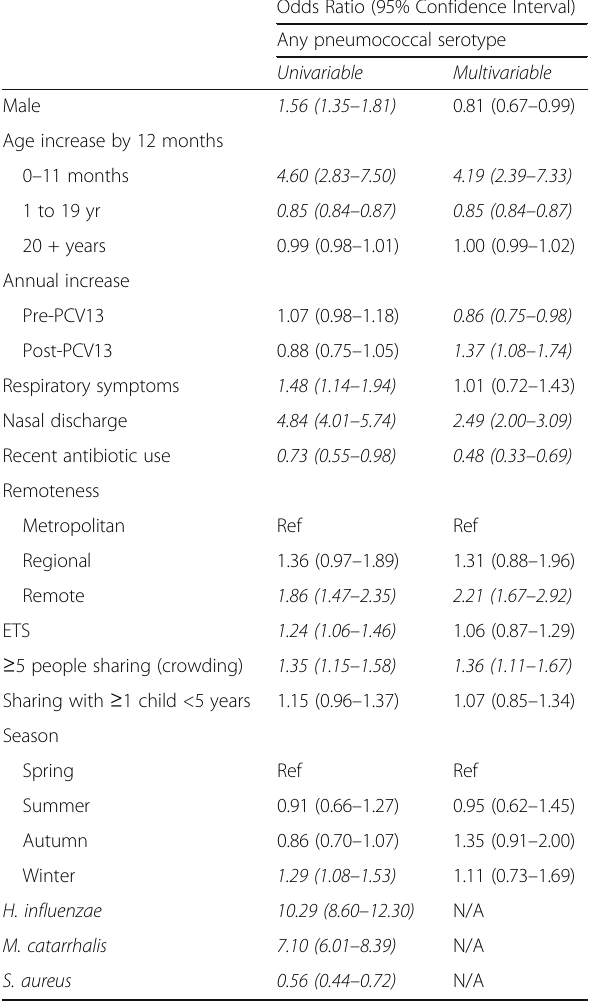
Table 3 Univariable and multivariable analysis of risk factors for carriage of any serotypeable pneumococcus among Aboriginal people in Western Australia, August 2008 – November 2014 Odds Ratio (95% Confidence Interval) Any pneumococcal serotype Univariable